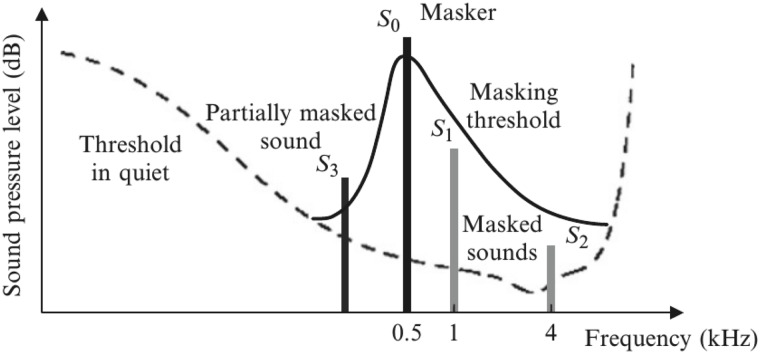
Masking threshold in auditory masking [31].